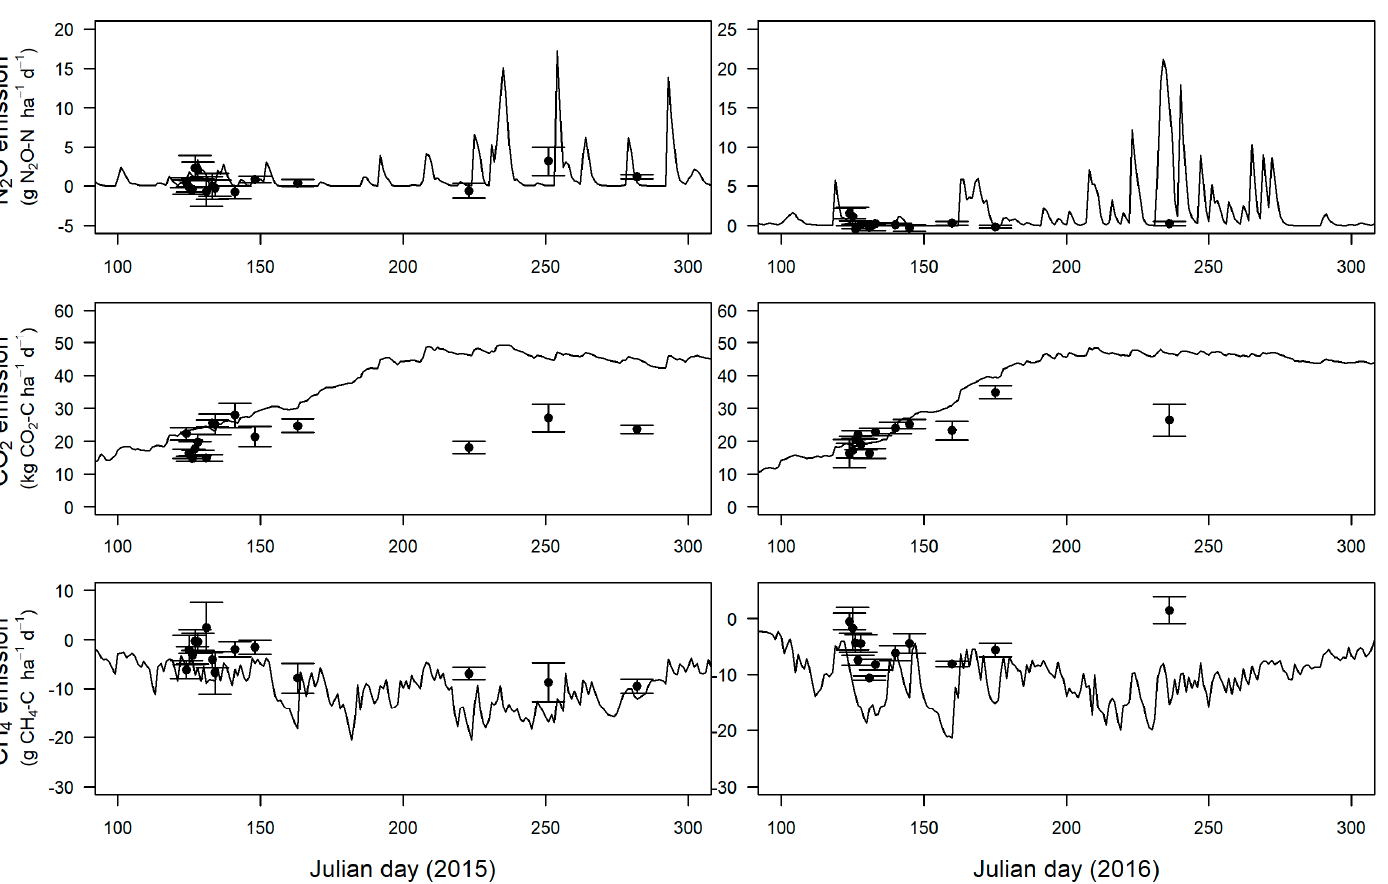
Figure 3. Measured (filled circle) and simulated (solid line) N 2 O, CO 2 and CH 4 emissions from soils of the warming treatment for 2015 and 2016 growing seasons. Error bars are standard deviations for 5 replicates.